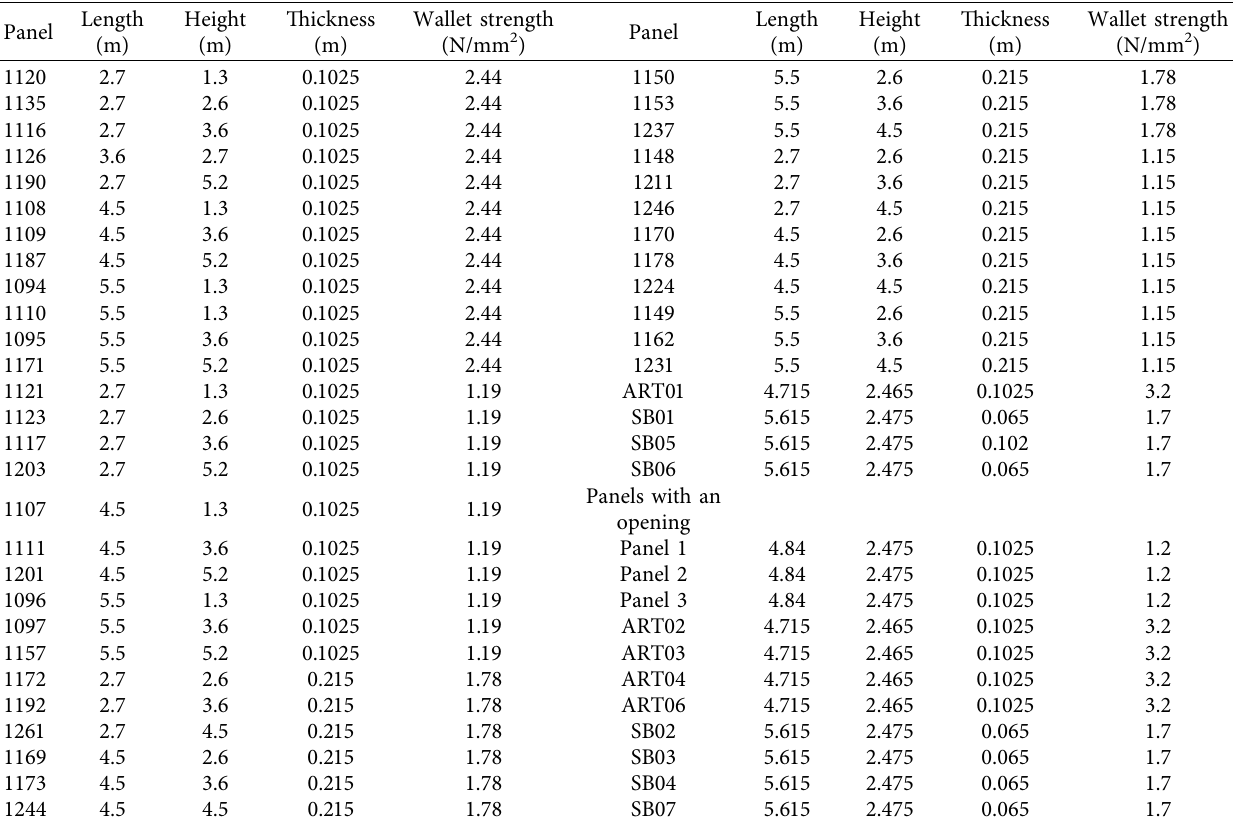
Table 1: Experimental